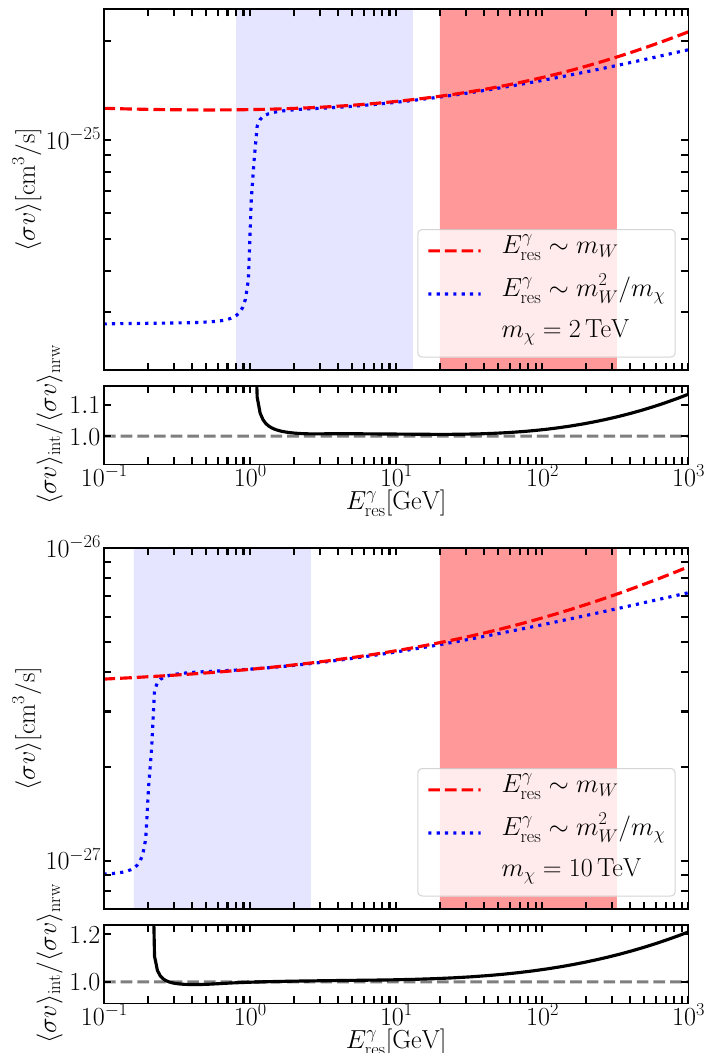
Figure 4 . Annihilation cross sections plotted as function of E γ cross section for the narrow resolution computed in [7]. The red-dashed line shows the intermediate resolution cross section. The light-grey (blue) area represents the region of validity for the narrow resolution case and the dark-grey (red) area represents the region of validity for the intermedi- ate resolution case. The ratio of the intermediate to narrow resolution annihilation cross section σv / σv is added below each plot. The results are shown for DM masses of m χ = 2 TeV (cid:31) (cid:30) int (cid:31) (cid:30) nrw (upper plot) and m χ = 10 TeV (lower